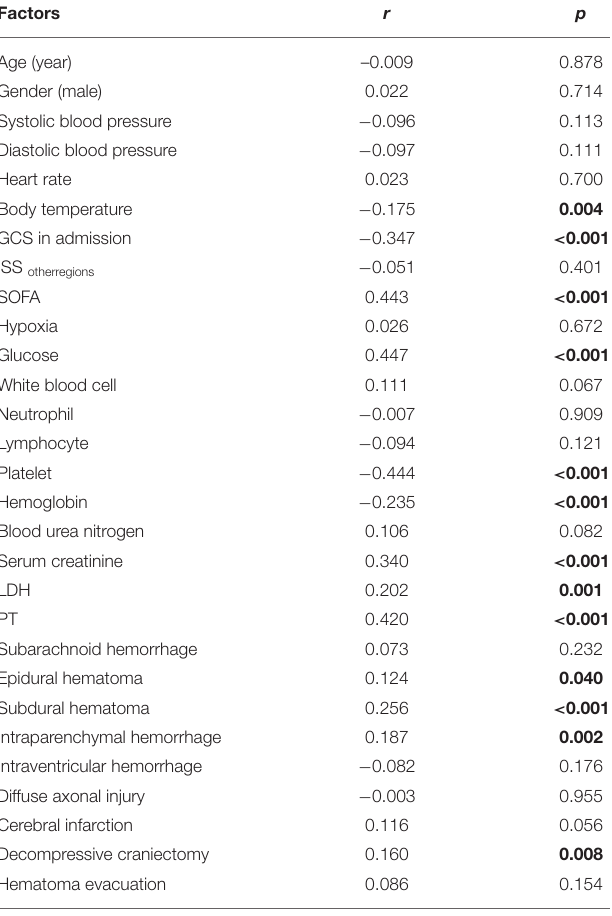
TABLE 2 | Correlation between other factors and LAR by Spearman analysis in patients with moderate to severe TBI. Factors